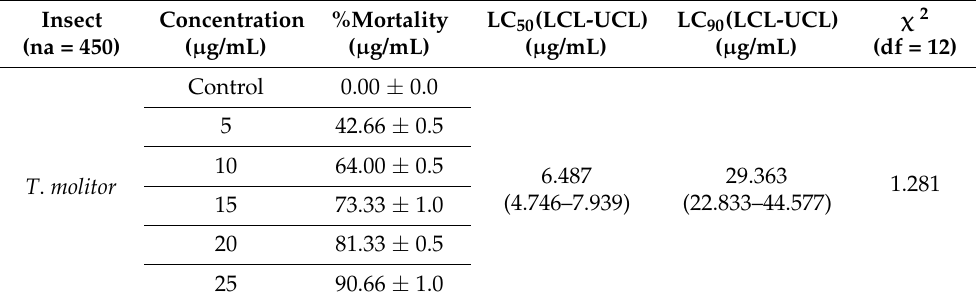
Table 2. Effect of green cluster copper nano-pesticide synthesized from entomopathogenic fungi M . robertsii against T . molitor at 24 h after treatment.